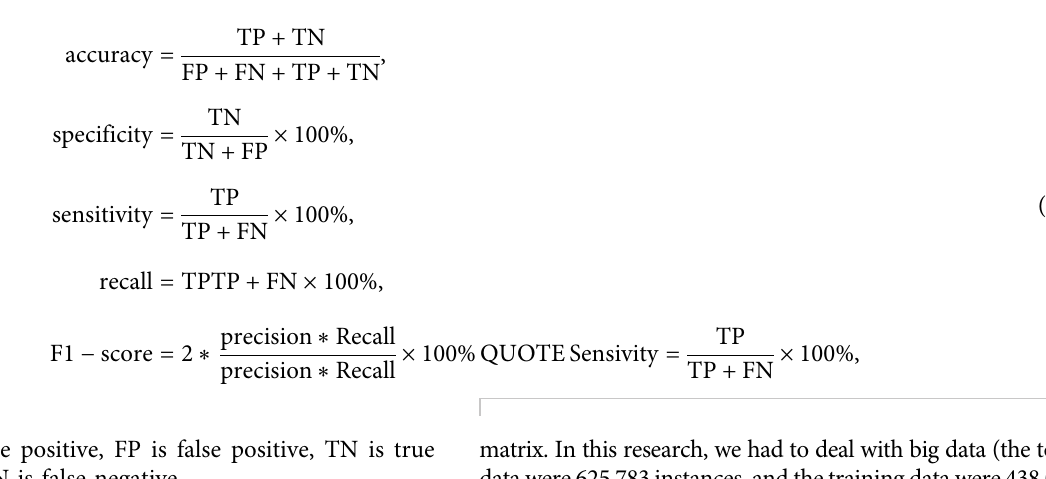
Figure 8: Architecture of the combined convolution neural network long short-term memory (CNN-LSTM)